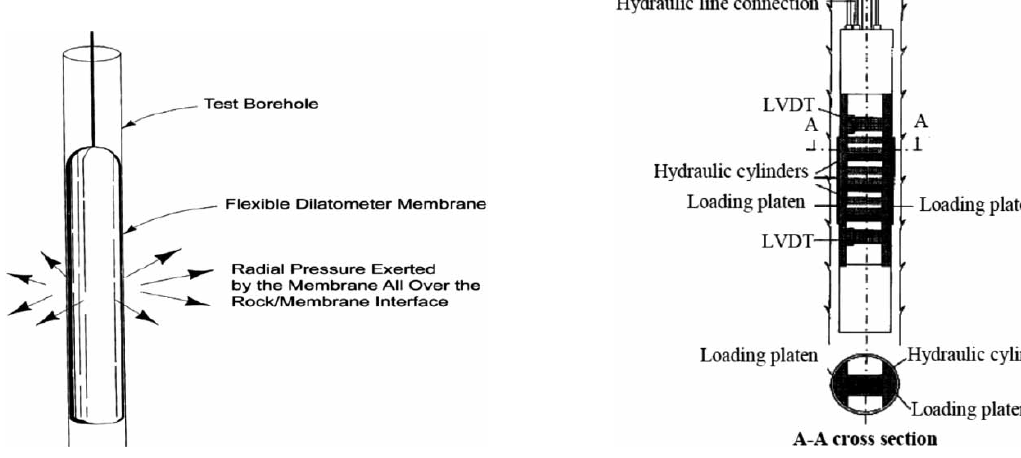
Fig. 4. Flexible dilatometer (USBR 2009) Fig. 5. Stiff dilatometer (Go¨ktepe et al.